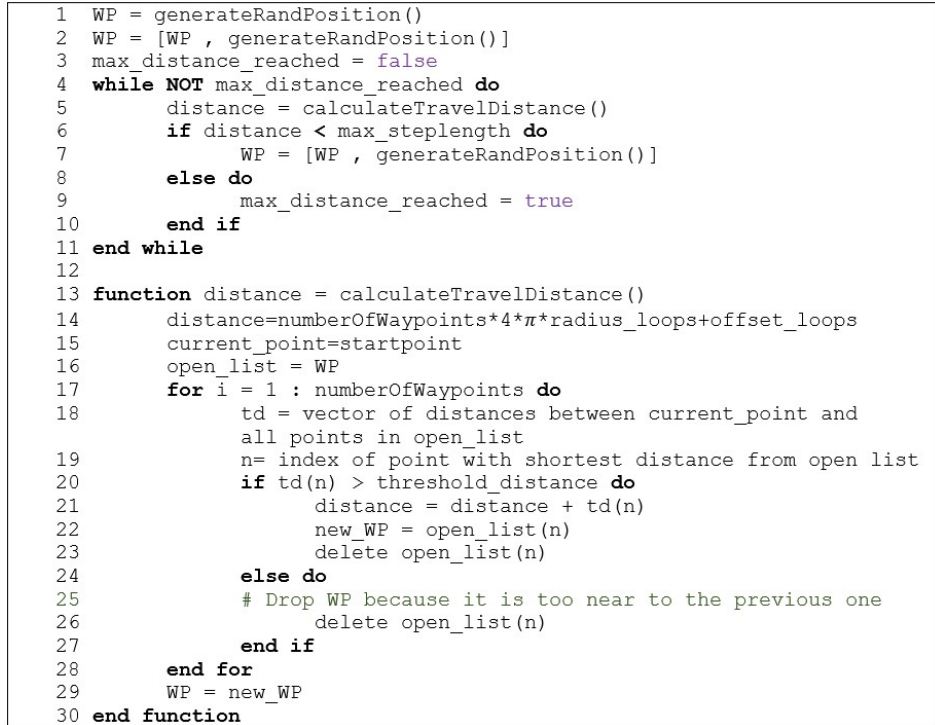
Figure 16. Pseudocode for waypoint creation of the bumblebee (BB) algorithm.